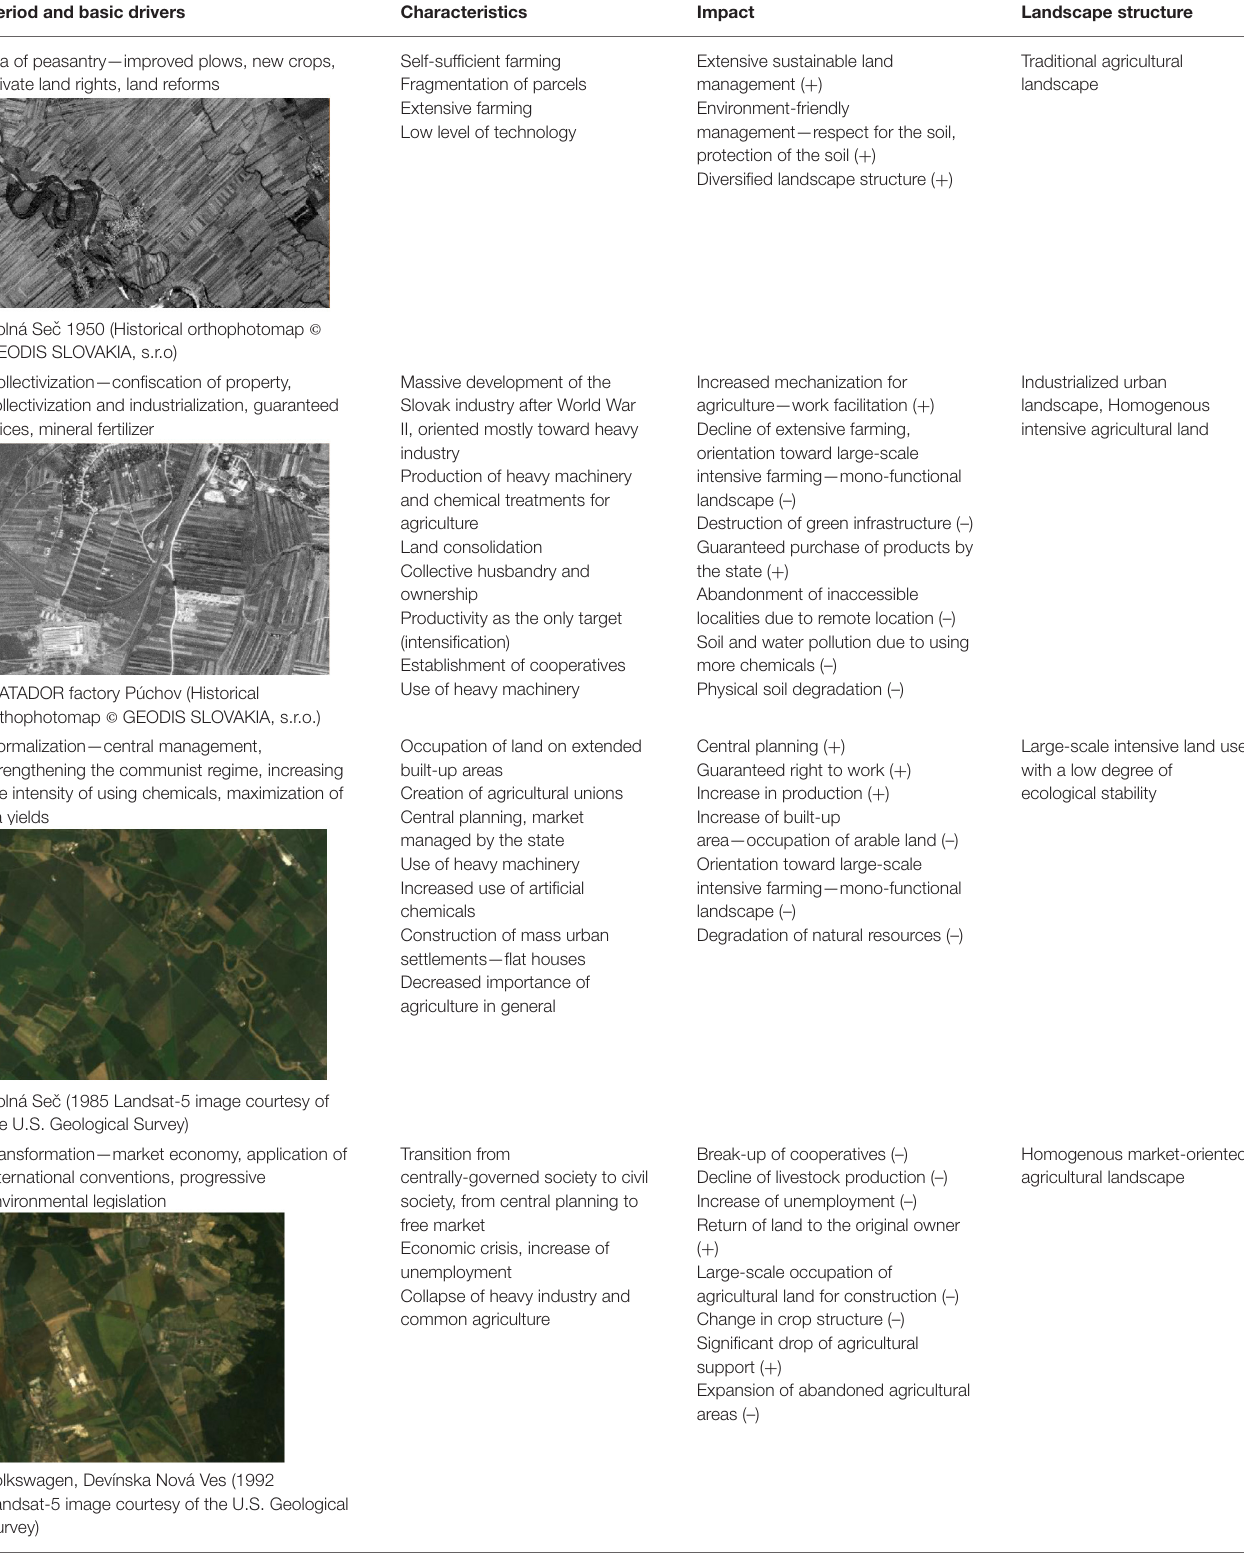
TABLE 1 | The periods of development of the agricultural landscape—main characteristics, drivers, impact on the landscape and the characteristic landscape structure. Period and basic